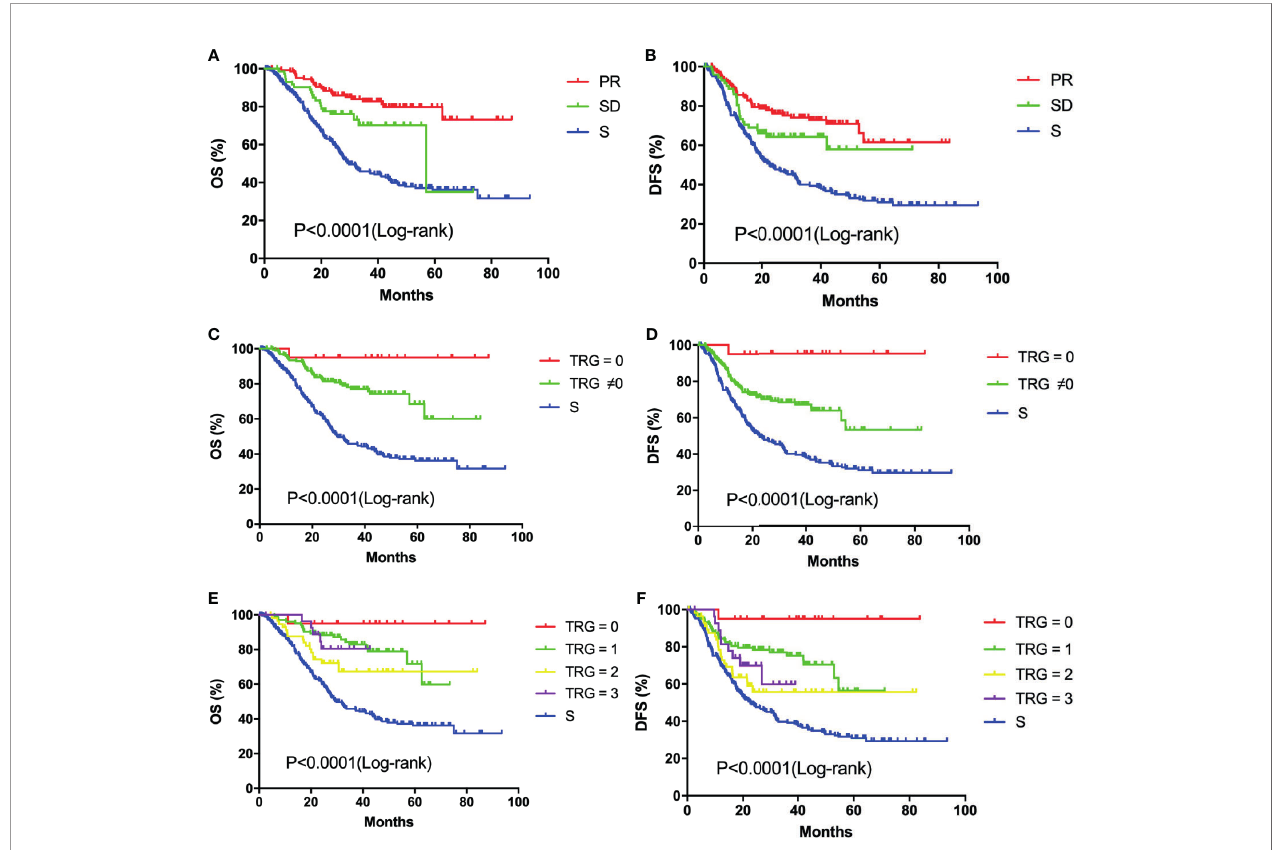
FIGURE 3 | Kaplan-Meier survival curves of overall survival and disease-free survival: OS (A) and DFS (B) analysis of patients in the PR (n=148), SD (n=73) and S (n=221) groups; OS (C) and DFS (D) analysis of patients in the TRG = 0 (n=20), TRG ≠ 0 (n=201) and S (n=221) groups; OS (E) and DFS (F) analysis of patients in the different TRG grade (0, n=20; 1, n=107; 2, n=62; 3, n=32) and S (n=221)